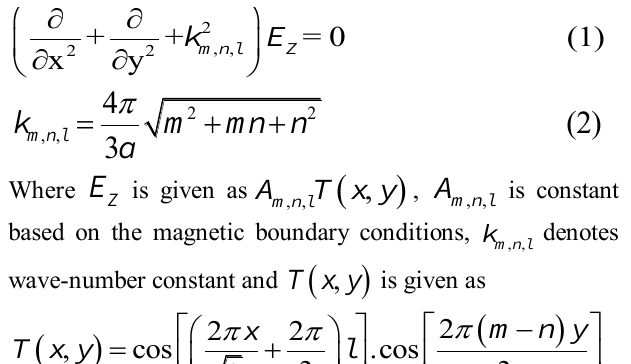
Figure 1: Coupling arrangement between dual degenerate modes of a triangular patch.